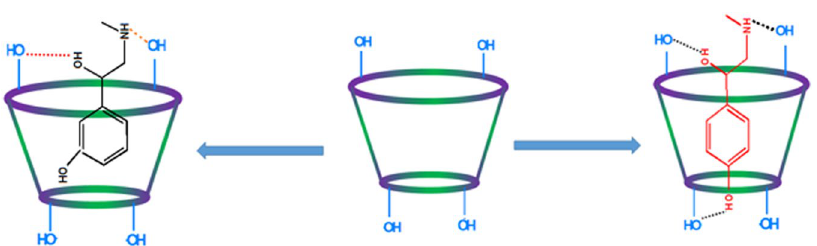
Figure 6. Schematic representation of the host:guest inclusion complexation through the more favorable wider rim of the cyclodextrin